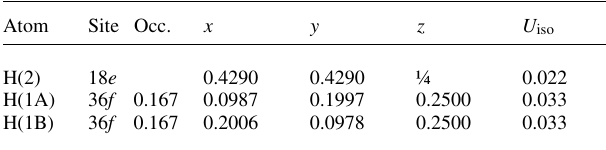
Table 2. Atomic coordinates and displacement parameters (in Å 2 )